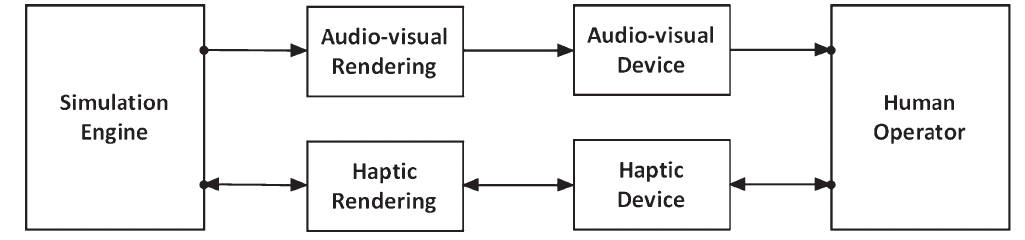
Fig. 6. A basicarchitectureforavirtualrealityapplicationclassicallyincludestwochannels:Theaudiovisualchannelandahapticchannel. Those two channels with the relative renderings realize the connection between the simulation engine and the human operator. From Salisbury